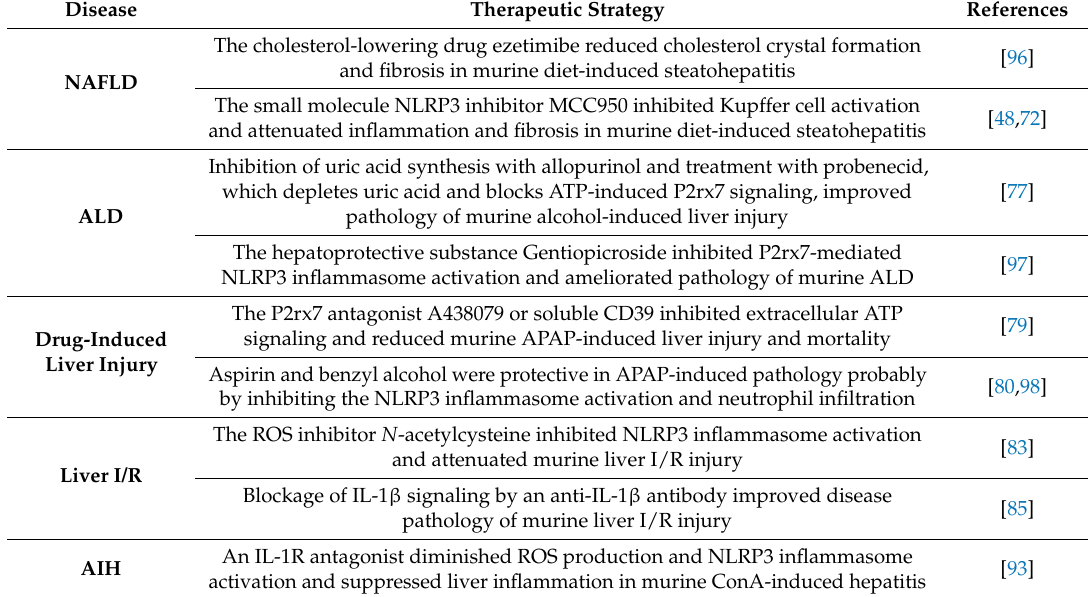
Table 2. Potential therapeutic strategies targeting the NLRP3 inflammasome pathway in sterile liver